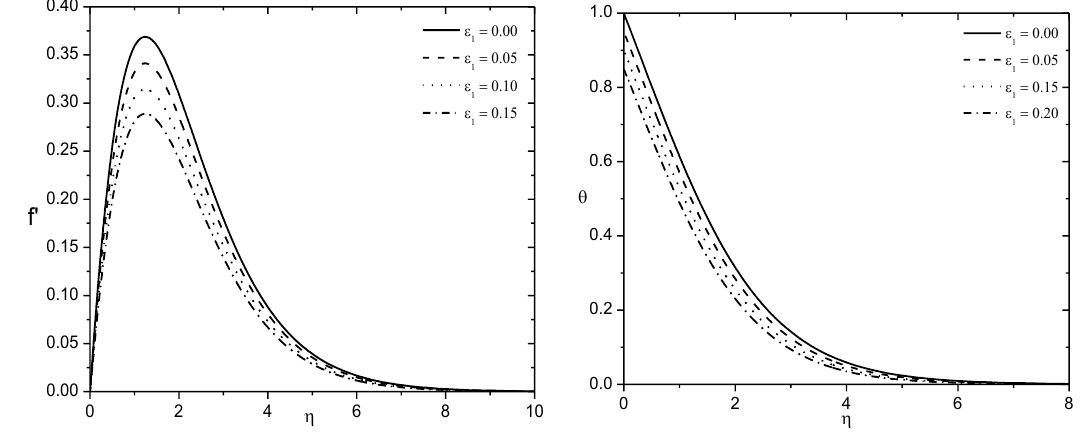
 on the Velocity Figure 8. Effet of Figure 7. Effet of 1